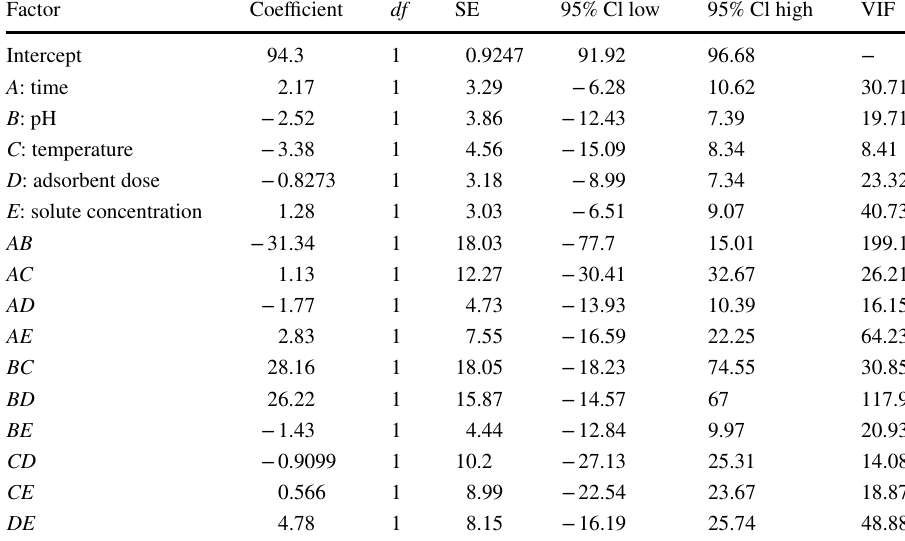
The combined effect of solute concentration and adsor- bent dose on percentage dye removal was represented in Fig. 22. In this case, the dye removal percentage was maxi- mum at higher amount of adsorbent dose and lower value of solute concentration. The interaction effect of solute conc. and pH on dye removal was shown in Fig. 23. Here, the dye removal efficiency was higher at low pH when solute con- centration was at high region.